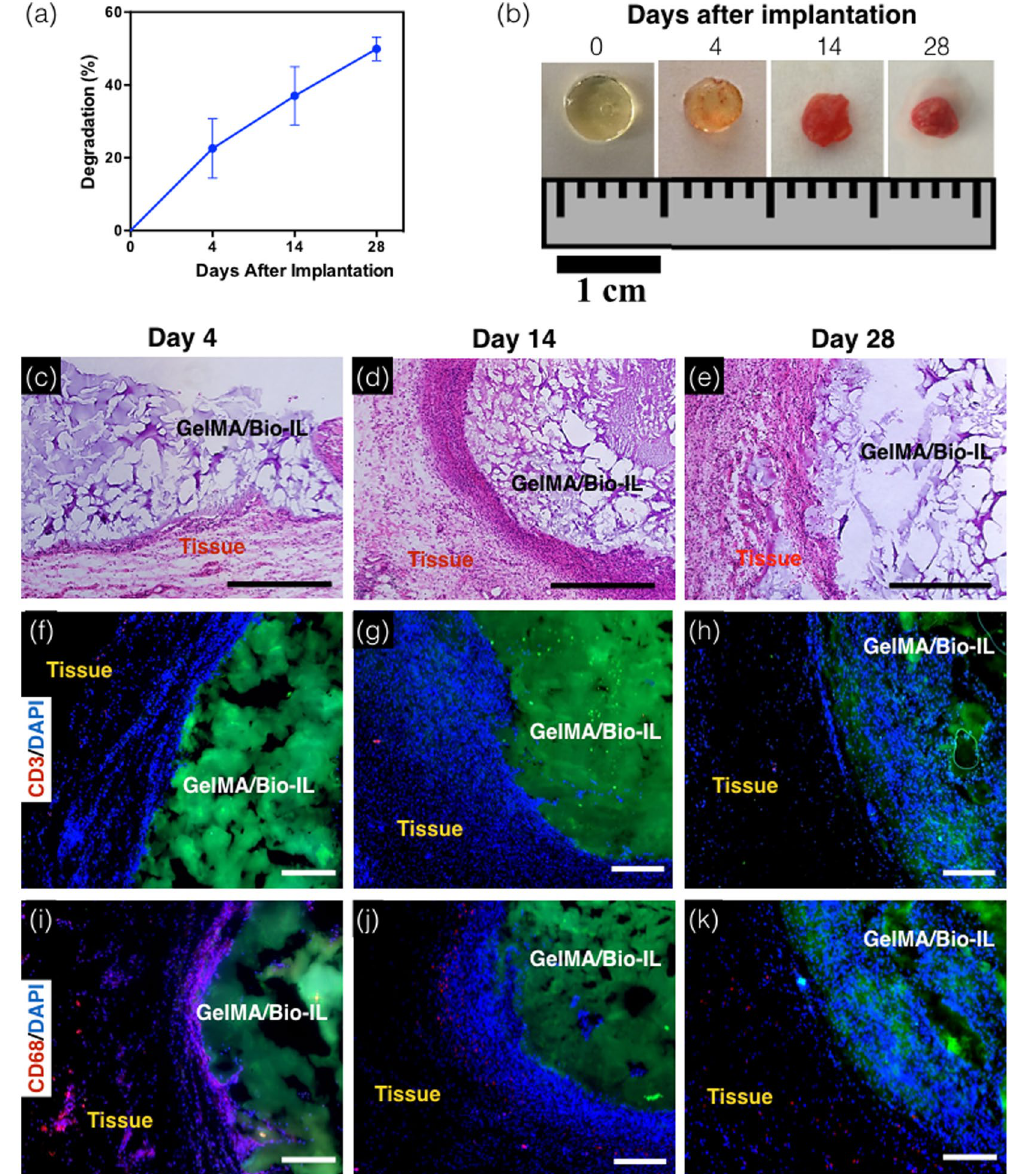
Figure 6. In vivo biodegradation and biocompatibility of GelMA/Bio-IL composite hydrogels using a rat subcutaneous model. ( a , b ) Evaluation of the in vivo degradation of GelMA/Bio-IL on days 0, 4, 14 and 28 post implantation (n = 4). ( a ) In vivo degradation of GelMA/Bio-IL hydrogels based on weight loss of the implants. The in vivo degradation profile of GelMA/Bio-IL hydrogels exhibited an approximately linear behavior throughout 28 days after implantation. ( b ) Images of the GelMA/Bio-IL composite hydrogels at 0, 4, 14, and 28 days after implantation. ( c – e ) Hematoxylin and eosin (H&E) staining of GelMA/Bio-IL sections after ( c ) 4, ( d ) 14, and ( e ) 28 days of implantation (scale bars = 500 µ m). The H&E images shows a negligible amount of inflammatory cells. ( f – h ) Fluorescent immunohistochemical analysis of subcutaneously implanted GelMA/Bio-IL hydrogels showing no significant local lymphocyte infiltration (CD3) at days ( f ) 4, ( g ) 14 and ( h ) 28 (scale bars = 200 µ m), and significant macrophage (CD68) presence at day ( i ) 4, which disappeared at days ( j ) 14 and ( k ) 28 (scale bars = 200 µ m). Green, red and blue colors in ( f – k ) represent the GelMA/Bio-IL hydrogels, the immune cells, and the cell nuclei (DAPI). 1% VC, 1.5% TEOA, and 0.1 mM Eosin Y at 120 s light exposure were used to form the hydrogels. All hydrogels were synthesized using 15% final polymer concentration and 50/50 GelMA/Bio-IL